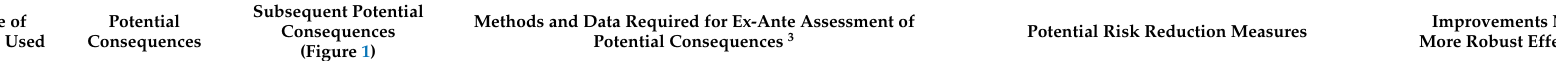
Methods and Data Required for Ex-Ante Assessment of Potential Consequences 3 Potential Risk Reduction (Figure 1)